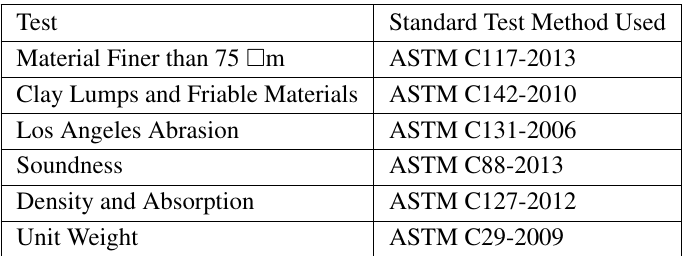
Table 6. Characterization Program of recycled